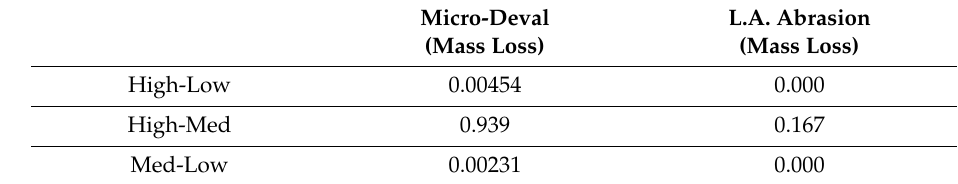
Table 2. Tukey’s comparisons of mean test